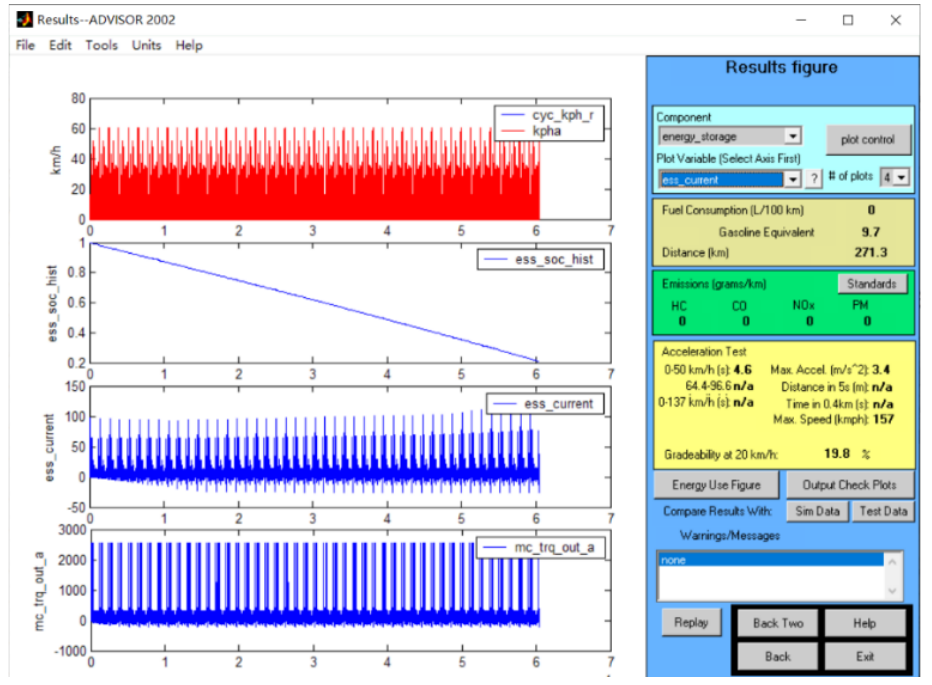
Figure 20. Multi-condition simulation results.